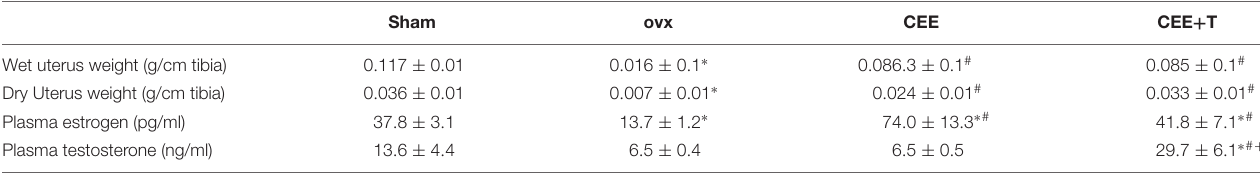
TABLE 1 | Uterine weight and sex steroid hormone levels in SHAM, ovariectomized (OVX), OVX treated with conjugated equine estrogens (CEE) and OVX treated with CEE plus testosterone (CEE + T) female spontaneously hypertensive rats. Sham ovx CEE CEE + T Wet uterus weight (g/cm tibia)